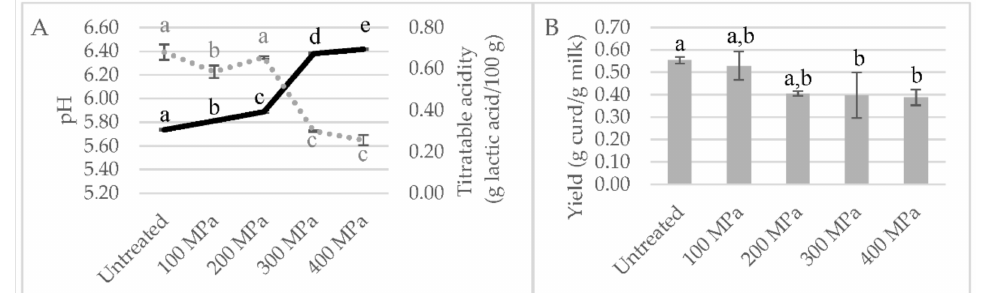
Figure 3. Focused screening study results: ( A ) milk pH values (continuous line) and titratable acidity (dots line); ( B ) yield expressed in g of curd per g of high-pressure processing (HPP)-treated milk at 100, 200, 300 and 400 MPa for 5 min after 48 h of collection and transformed after 24 h storage. Different non-capital letters (a, b, c, d, e) indicate statistically significant differences between the different conditions ( p <